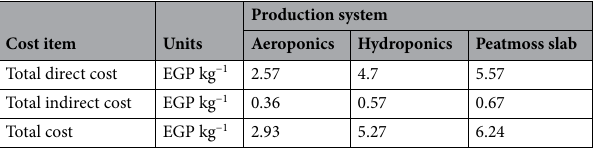
Table 4. The total production costs of basil plants grown in different soilless